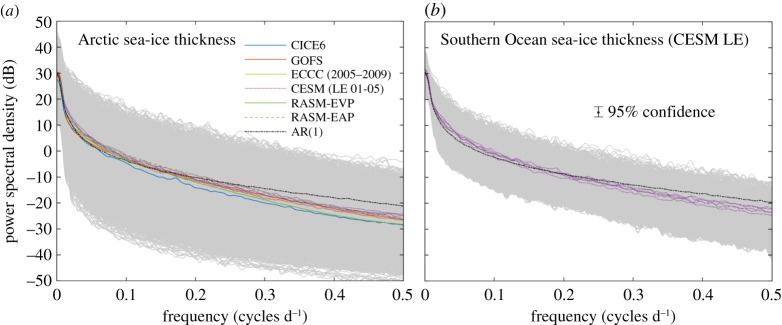
Power spectral density of perennial concentration-weighted sea-ice thickness hi (a) for the Arctic for all models and (b) for the Southern Hemisphere from the CESM Large Ensemble. Spectra of individual model grid cells are displayed in grey, and the mean of each simulation's spectra appear in colour, including individual traces for CESM ensemble members 01 to 05. All spectra represent the period 2000–2004 (except for ECCC, 2005–2009). The GOFS spectral mean has been obtained by sampling one model cell per each 10 × 10 grid point mat due to the resolution of that model. RASM spectra are shown for two rheological configurations: EVP as in figure 1, and EAP, corresponding to previously published results [21,22]. Converged Monte Carlo AR(1) spectral estimates appear in black, and the confidence interval displayed in (b) also applies to (a). The limited spread of spectra for the Southern Ocean relative to the Arctic is due to the comparatively small area of perennial ice that occurs in the Southern Hemisphere.